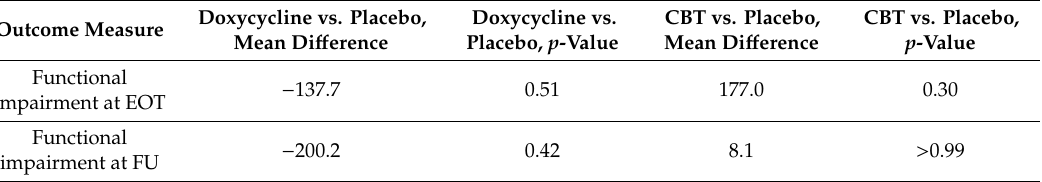
Table 5. Treatment e ff ect on functional